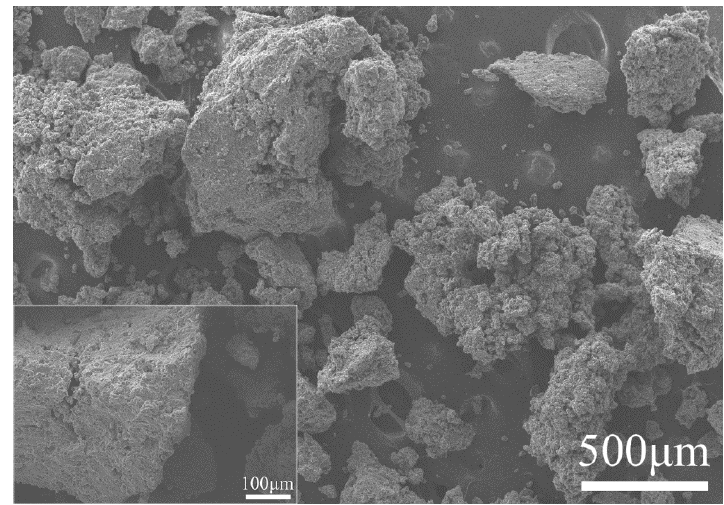
Figure 5. SEM images of rubber.